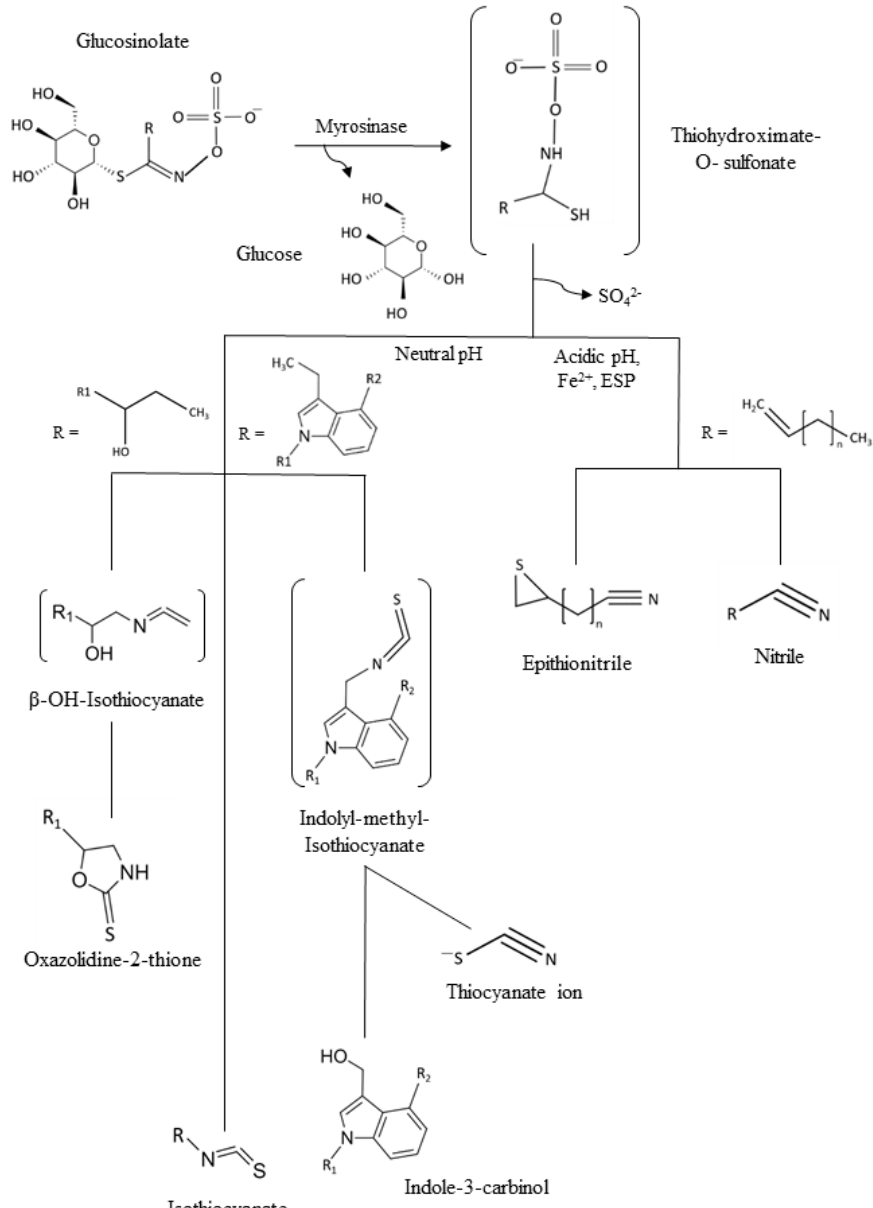
Figure 1. General scheme of the glucosinolates (GSLs) and common hydrolysis products. ESP: Epithiospecifer proteins.